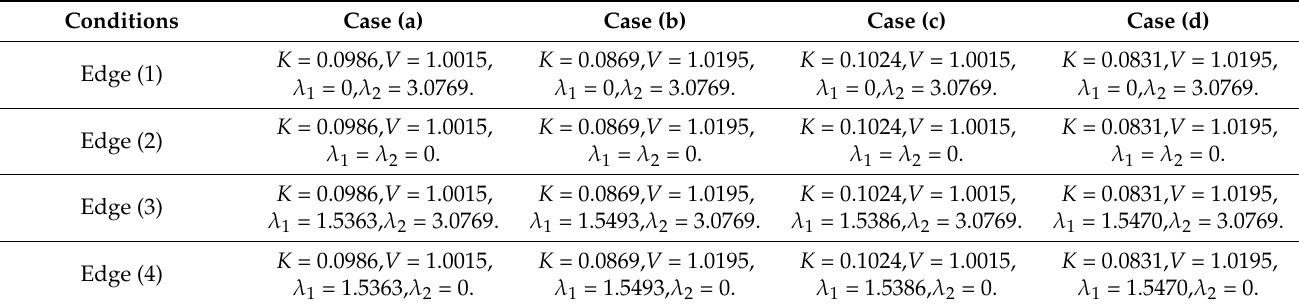
Table 1. Values of K , V , λ 1 , and λ 2 under Edges (1)–(4) and cases (a)–(d).